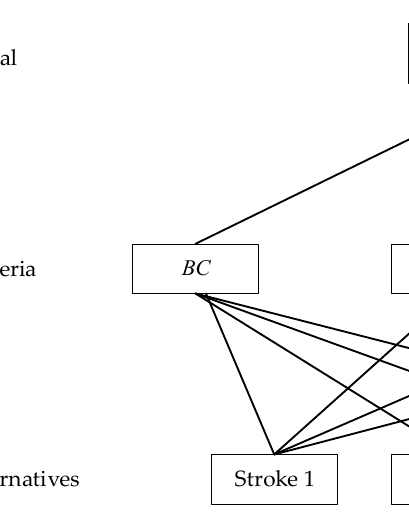
Figure 3. Analytic hierarchy model of strokes importance.